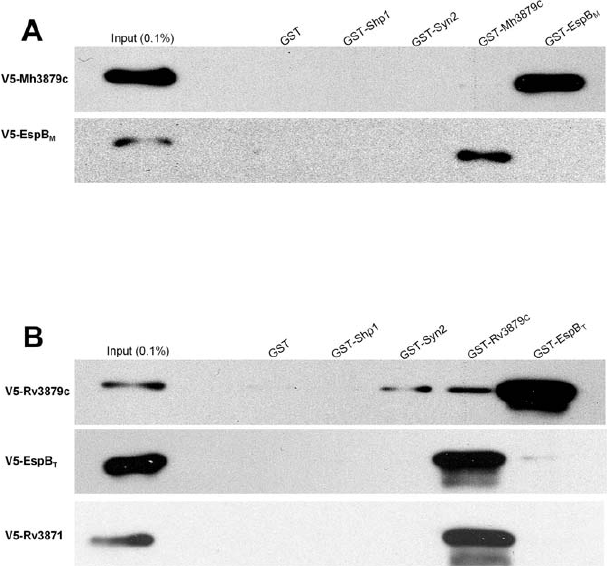
Figure 5. GST Pulldown Analysis of EspB and Rv3879 Interactions (A) Agarose beads with immobilized GST, GST-SHP1, GST-syntaxin2, GST- Mh3879c, and GST-EspB M were incubated with lysates of E. coli that express V5-Mh3879c and V5-EspB M . (B) Agarose beads with immobilized GST, GST-SHP1, GST-syntaxin2, GST- Rv3879c, or GST-EspB T were incubated with lysates of E. coli that express V5-Rv3871, V5-Rv3879c, and V5-EspB T . Proteins from cell lysates retained on the beads after washing were separated by SDS-PAGE and detected by western blotting with an antibody against V5. To the right of each